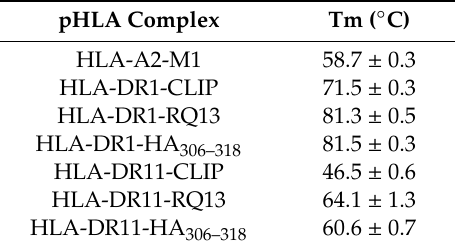
Table 2. pHLA stability.